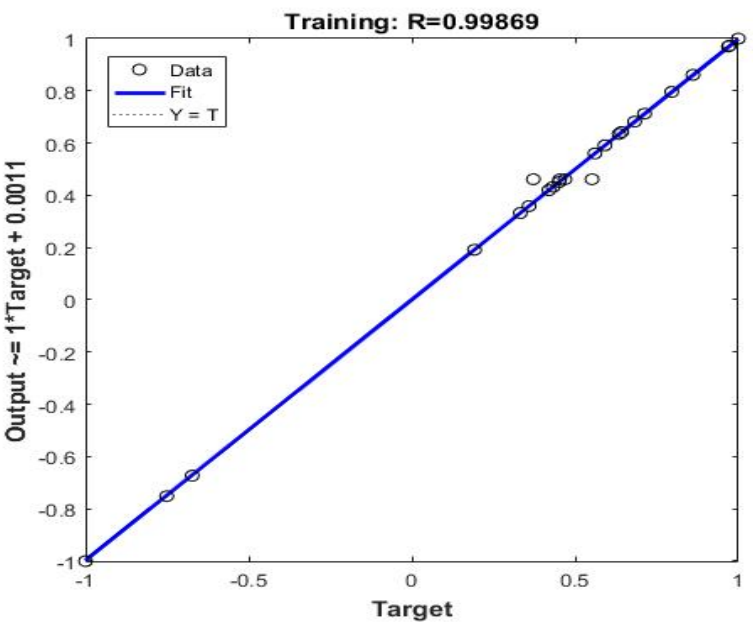
Figure 19. The experimental and predicted data of normalized decontamination. Table 6. Weights and biases of the BP-ANN in the input hidden layers (wi and bi) and the hidden output layers (wj and bj). Number